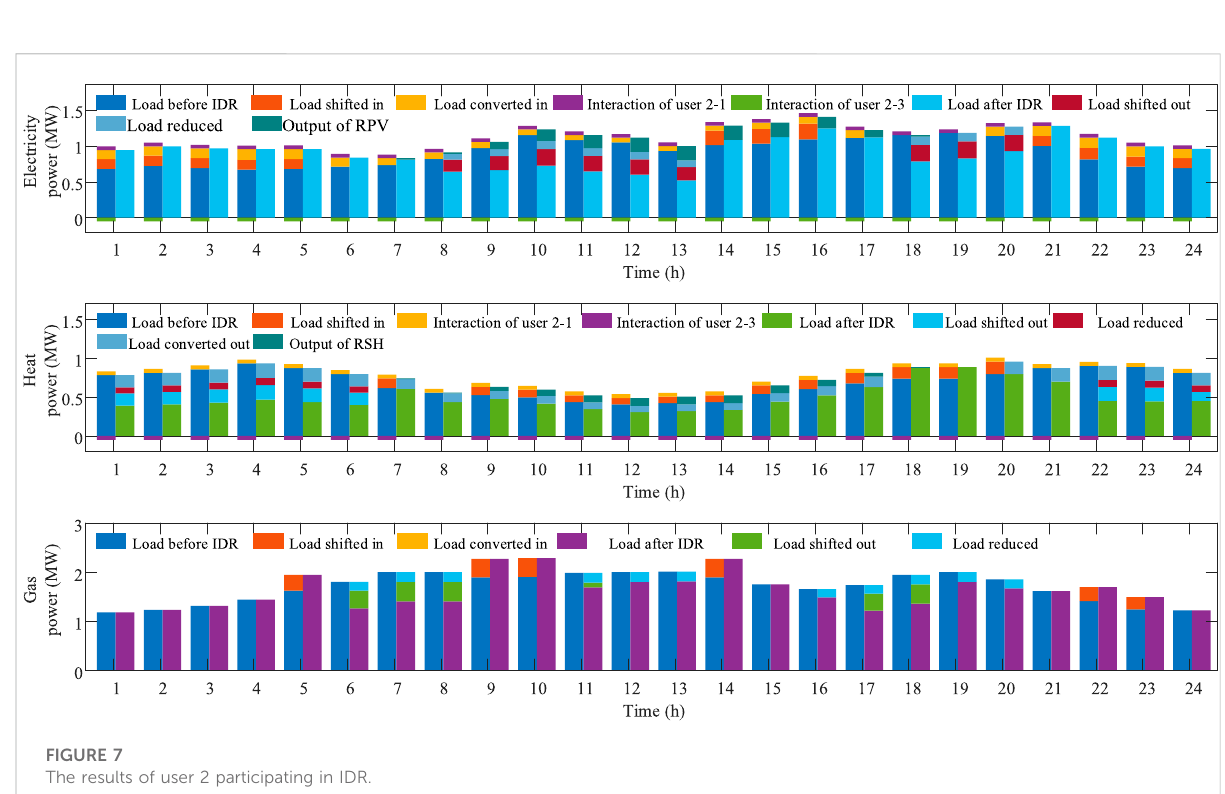
FIGURE 7 The results of user 2 participating in